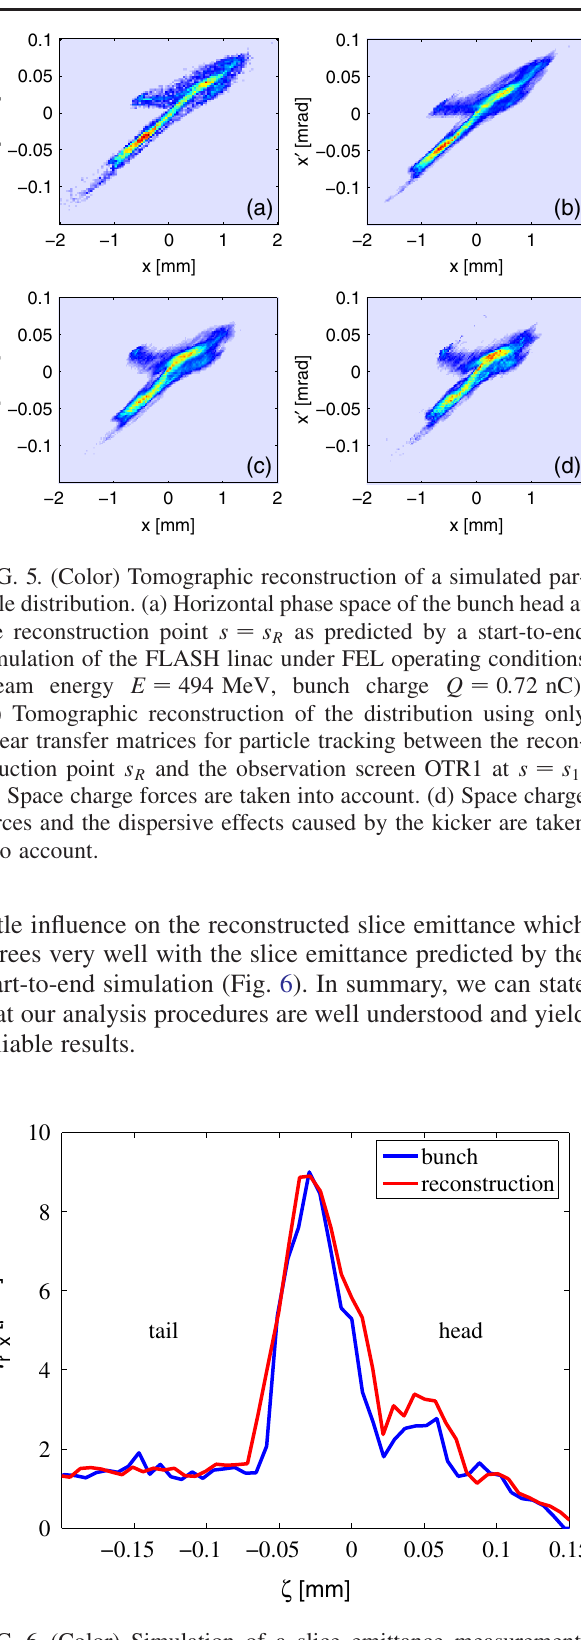
FIG. 6. (Color) Simulation of a slice emittance measurement. Blue curve: slice emittance as predicted by the start-to-end simulation of FLASH. Red curve: reconstructed slice